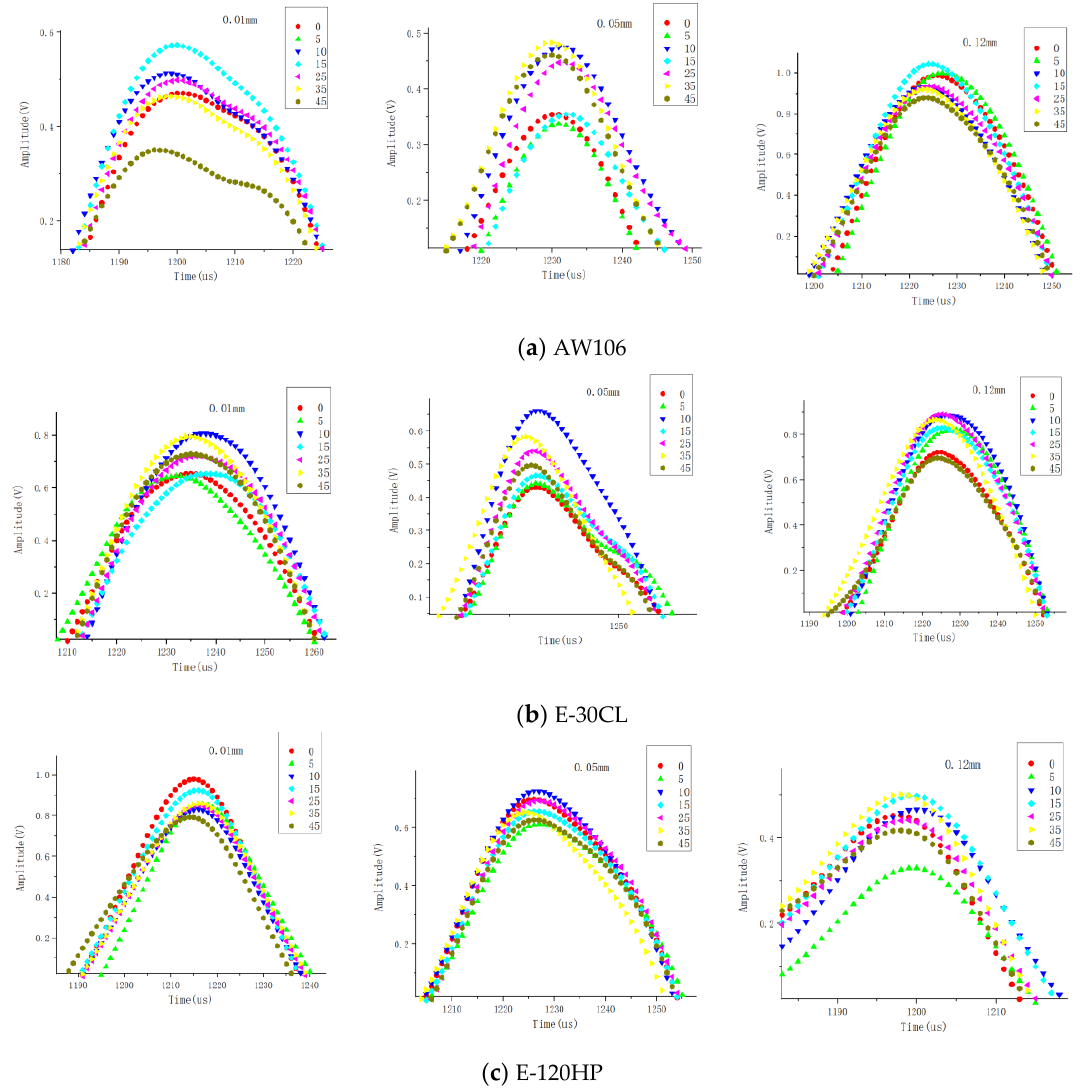
Figure 8. Effect of accelerated aging of adhesive on the receiving signal. ( a ) adhesive AW106, with thickness of 0.01, 0.05, and 0.12 mm; ( b ) adhesive E-30CL, with thickness of 0.01, 0.05, and 0.12 mm; ( c ) adhesive E-120HP, with thickness of 0.01, 0.05 and 0.12 mm.